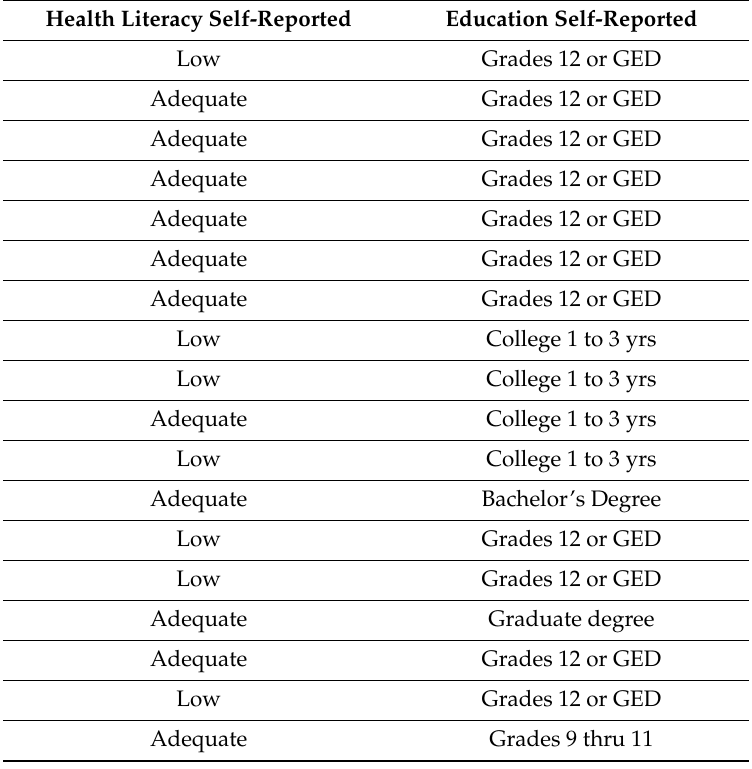
Table 3. Education by Health Literacy among Individuals